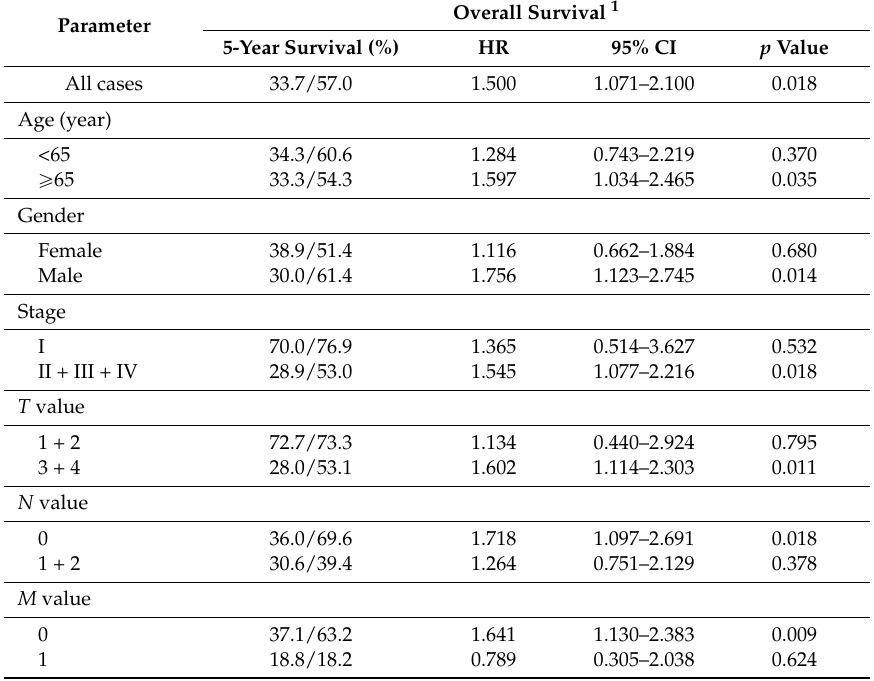
Table 4. Multivariate analysis of the influence of STEAP1 expression in subgroups according to clinical parameters on overall survival in colorectal cancer